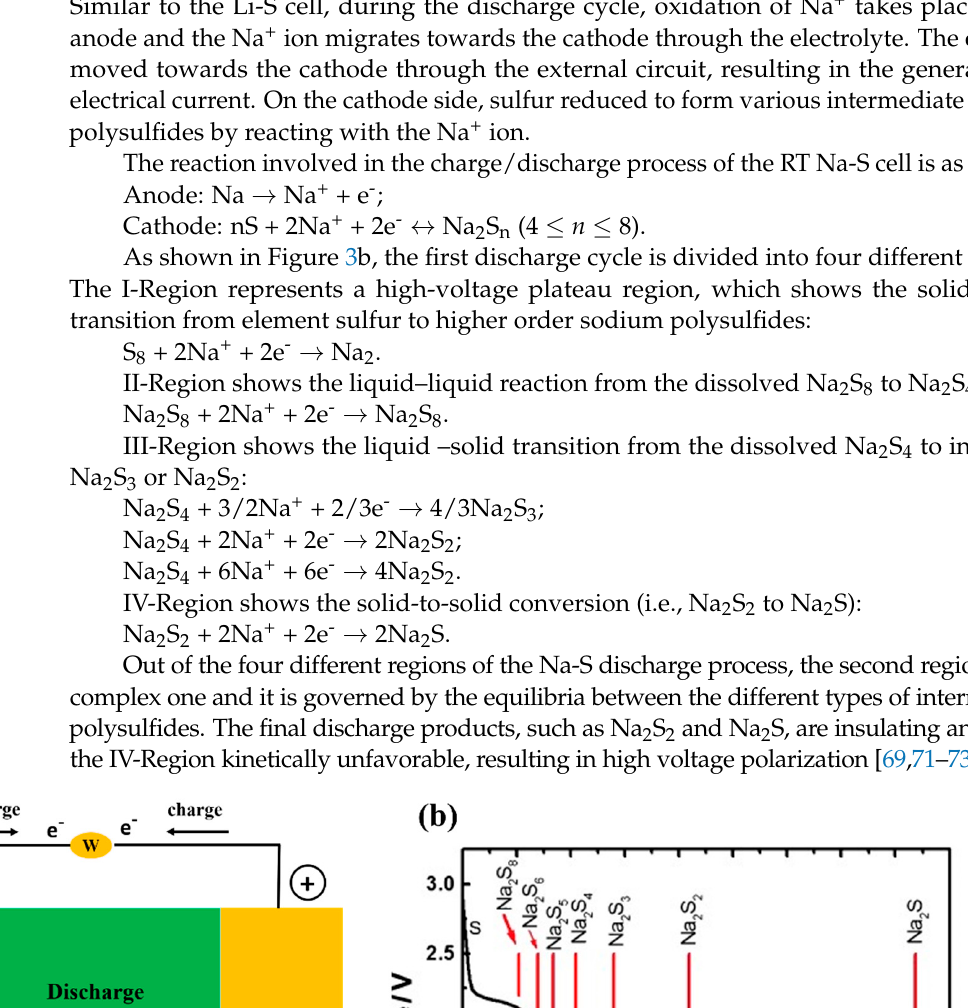
Batteries 2023 , 9 , 110 6 of 28 Figure 2. Schematic representation of HT Na/S battery with molten solid electrolyte, molten sodium anode and molten sulfur cathode.